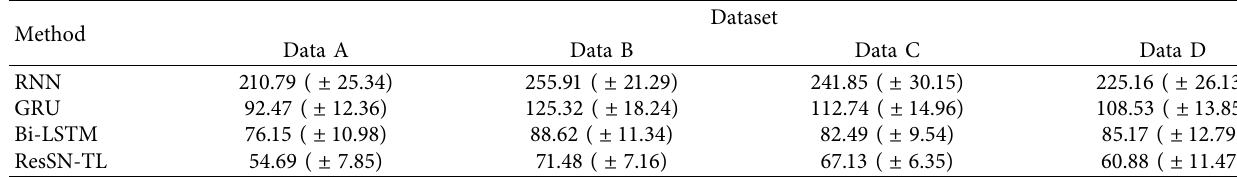
Table 9: RMSE results of hand-out cross